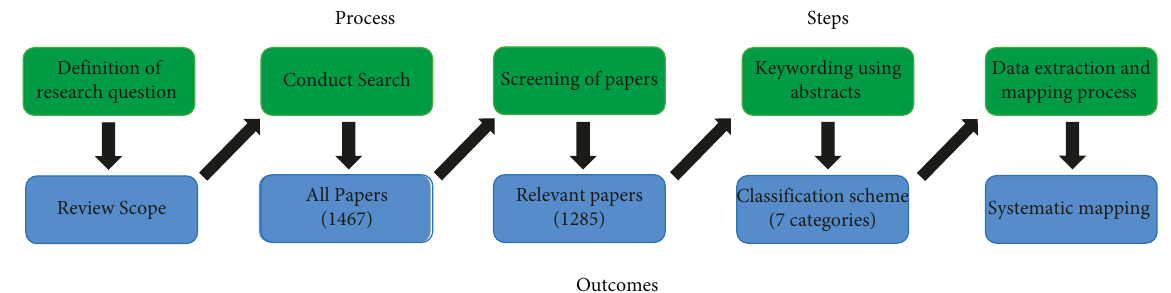
Figure 1: The systematic mapping process. Adapted from